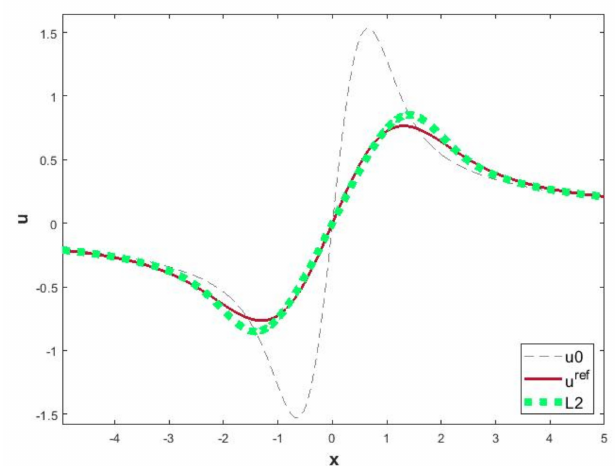
Figure 12. The graphs of the u functions for time-dependent coefficients. Here, u 0 is the initial function u ( x , t = 0.5 ) , u ref is the analytical solution at the final time t fin = 1, and L2 is the corresponding numerical solution served by the L2 (0, 1 / 2 , 1 / 2 , 1 / 2 , 1 / 2 ) algorithm for h = 7.8 × 10 − 3